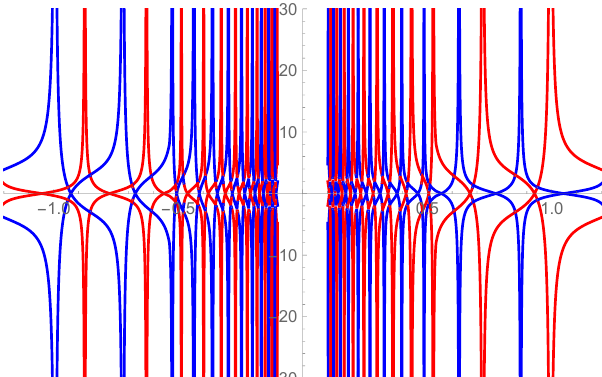
Figure 4 . Eigenvalues of (cid:0) G (cid:0) 1 (0 ; k ) for M=b ’ 0 : 0013 as a function of k x . Red and blue curves represent two di(cid:11)erent sets of eigenvalues. This corresponds to an e(cid:11)ective band structure of the topological Hamiltonian of this system, which captures the same topological structure of the original system. This (cid:12)gure also agrees qualitatively with the density plot of spectral densities in the ! - k x plane of the original system. Figure taken from